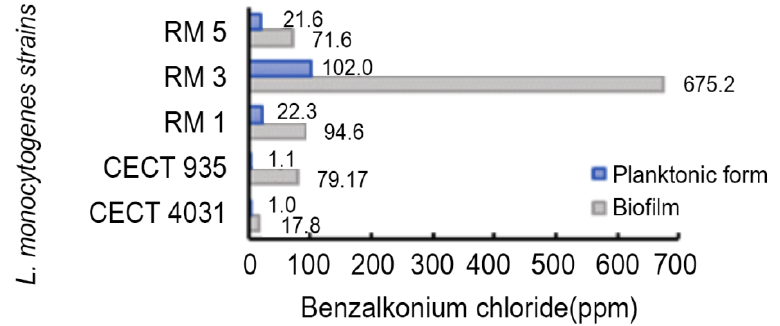
Figure 7. LD 90 estimated values of L. monocytogenes tested strains in biofilm and in the planktonic form exposed to BaC.